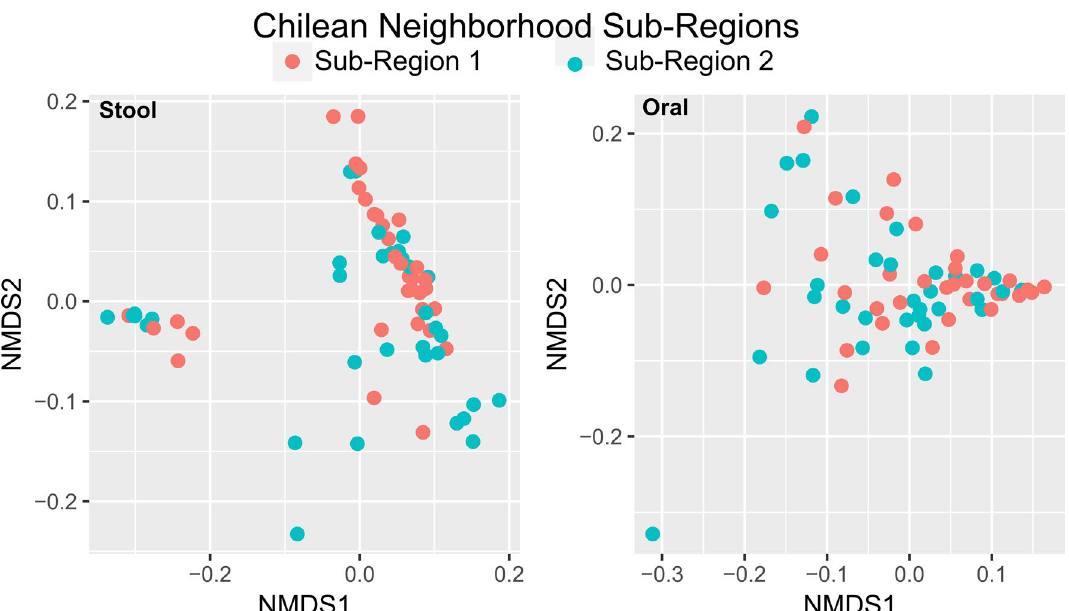
Figure 6. Oral ( n = 66) and stool ( n = 67) microbiota diversity between populations from different neighborhoods (sub-region 1 and sub-region 2) in Santiago, Chile as shown by NMDS using weighted UniFrac distance (stool: PERMANOVA r 2 = 0.026, p = 0.159; oral: PERMANOVA r 2 = 0.032 p = 0.089). The boundaries of the neighborhoods are shown in Supplementary Fig.